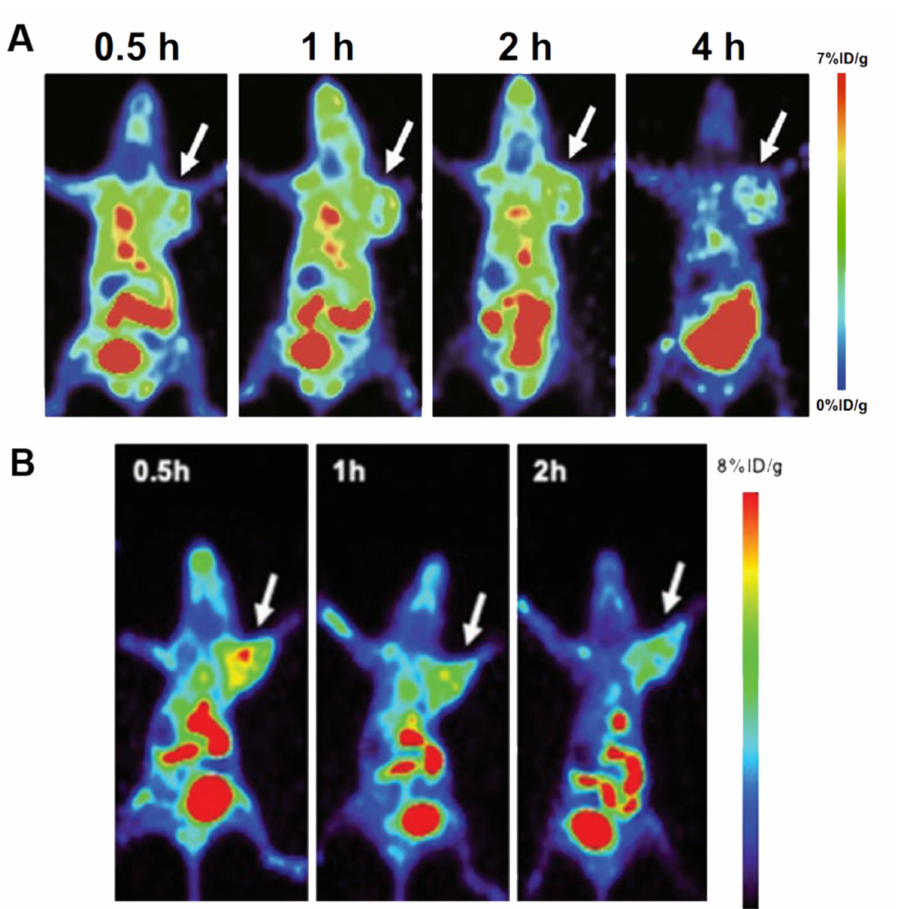
Figure 10. ( A ) micro-PET static imaging was performed at 0.5, 1, 2, and 4 h after injection of Al 18 F-L-NETA-DBCO in MDA-MB-231 tumor-bearing mice pretreated with N3-DSPE-PEG-CCm231- UCNPs [221]. ( B ) PET imaging of 4T1 breast cancer-bearing mice at different time points in the N3(FA)-PEG-DSPE-RBC-UCNP group after injection of DBCO-L-NETA-Al 18 F